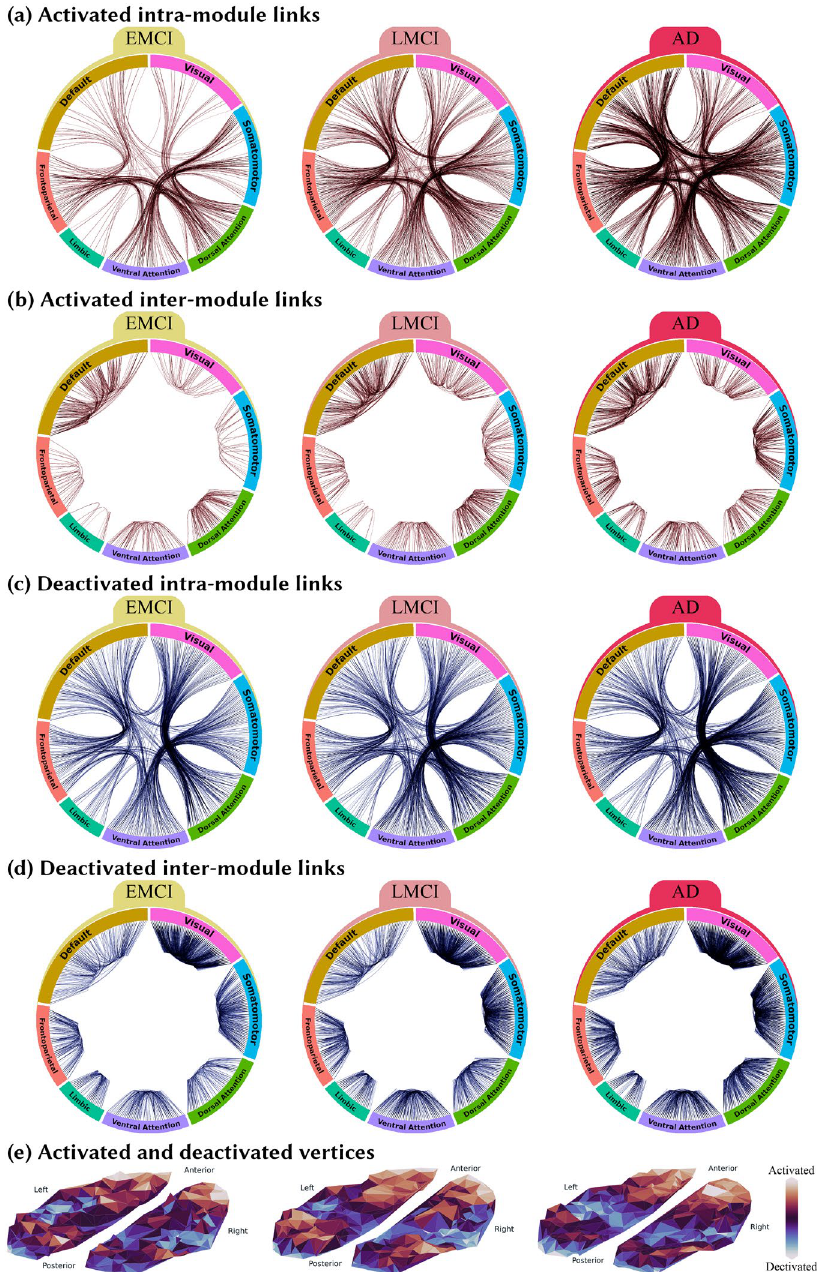
Figure 5. The alterations in the brain functional network induced by the disease progression. For each disease stage, the connectogram of the links with significantly higher (activated) or lower (deactivated) weights compared to the CN group is depicted in the top four panels: ( a ) connectogram of intra-module links activated in each disease stage compared to the CN group, ( b ) Connectogram of inter-module links activated in each disease stage compared to the CN group, ( c ) connectogram of intra-module links deactivated in each disease stage compared to the CN group, and ( d ) Connectogram of inter-module links deactivated in each disease stage compared to the CN group. For each disease group, the activated (deactivated) links compared to the CN group are defined as the significantly larger (smaller) elements of the matrix resulting from the subtraction of the disease network from the CN network. Diagrams are plotted based on the Hierarchical Edge Bundling algorithm 55 using ObservableHQ platform (https:// obser vable hq. com). This algorithm allows bundling the intra- module links to get a more elegant presentation. Panel ( e ) indicates the activation or deactivation in the vertices’ strength by showing the top-view spatial distribution of the activated or deactivated vertices similar to Fig.